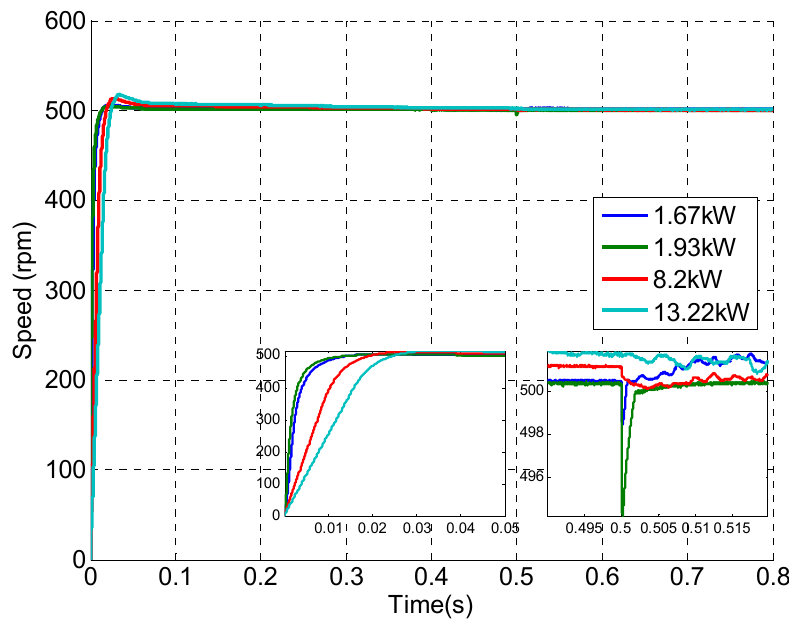
Figure 8. Speed response of FOSMC-PID speed controller for various load torque.